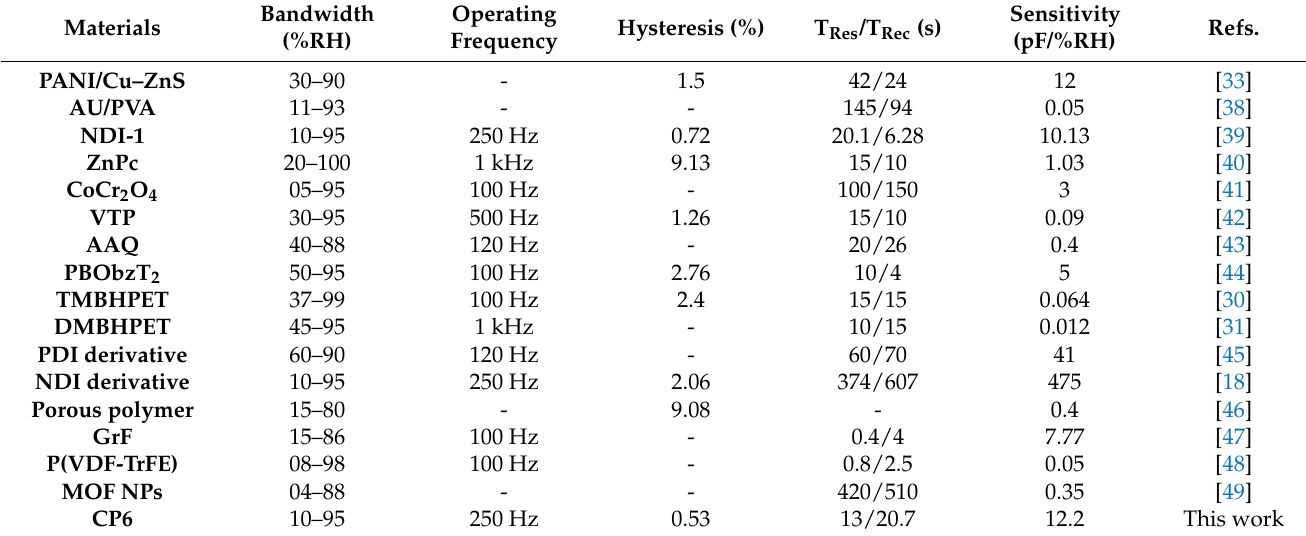
Table 1. A comparative study of the CP6 -based sensor with recently reported humidity